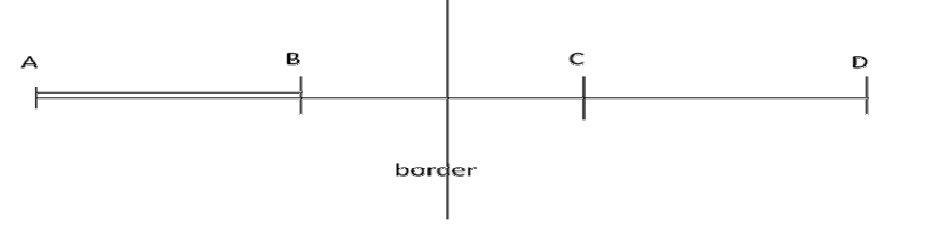
Figure 3. International corridor with four nodes and three links; improvement considered on A-B